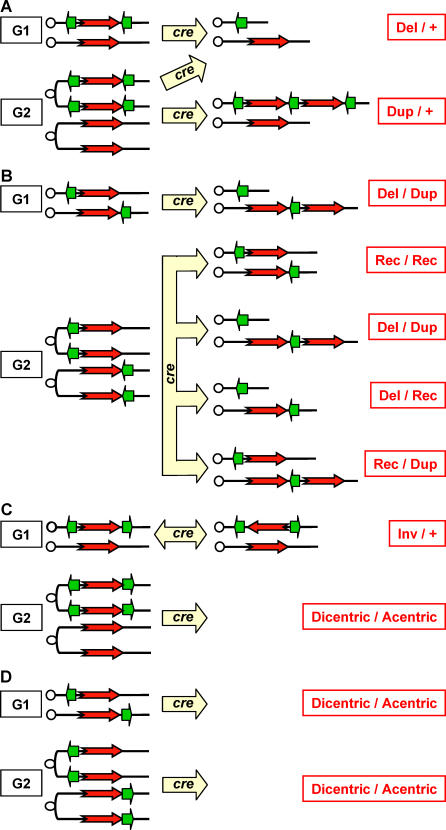
The Different Types of Chromosomal Rearrangements Produced by the Cre/loxP Recombinase SystemDeletions, duplications, or inversions can be produced depending on the relative orientation of the loxP sites, on their position on the homologous chromosome (i.e., in cis or in trans), and on the cell cycle stage during which the Cre-mediated recombination occurs (G1 or G2).(A) Recombination between loxP sites (green arrowhead) integrated in the same orientation in a cis configuration during the G1 phase can only generate a deletion of the region of interest (red arrow); the same configuration in the G2 phase can result in the creation of a deletion and a duplication.(B) The deletion and the corresponding duplication can also be obtained from a trans configuration in both G1 and G2 phases. This represents the best configuration to establish the deleted and duplicated chromosomes in the mouse, with both chromosomes compensating for each other with regard to genetic dosage, thus reducing the potential consequence of haploinsufficiency.(C and D) When the loxP sites are oriented in opposite directions in a cis configuration, an equilibrium with two forms, inverted and non-inverted, is obtained if the Cre is expressed in G1, while a more likely unstable recombined pair of acentric and dicentric chromosomes is generated if Cre reacts on loxP sites after the S phase or from a trans configuration. From all these recombinant alleles, only those containing the reconstituted mini-gene, however, will be retained during the selection in vitro. Recombinant ES-cell clones should be extensively characterized to verify the engineered chromosome (by Southern blot analysis, normal and quantitative PCR, or FISH).Del, deletion; Dup, duplication; Inv, inversion; Rec, one of the original recombinant alleles.